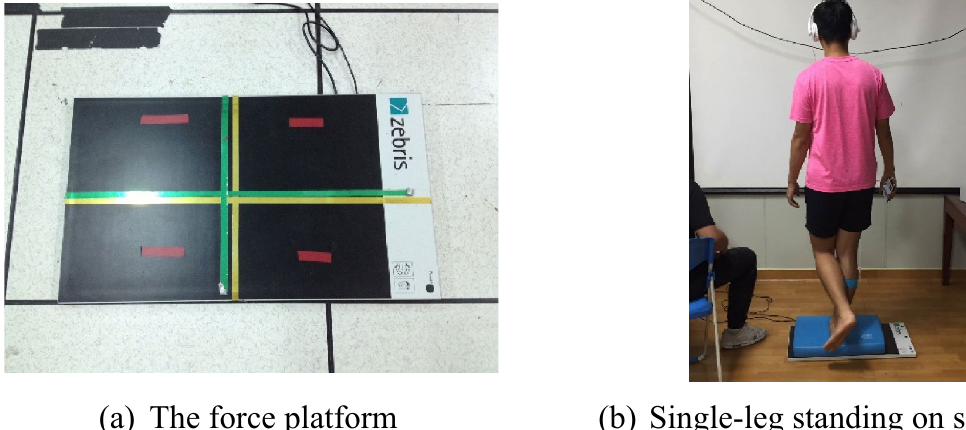
Figure 2. ( a ) The force platform and ( b ) test for single-leg standing on soft mat condition.